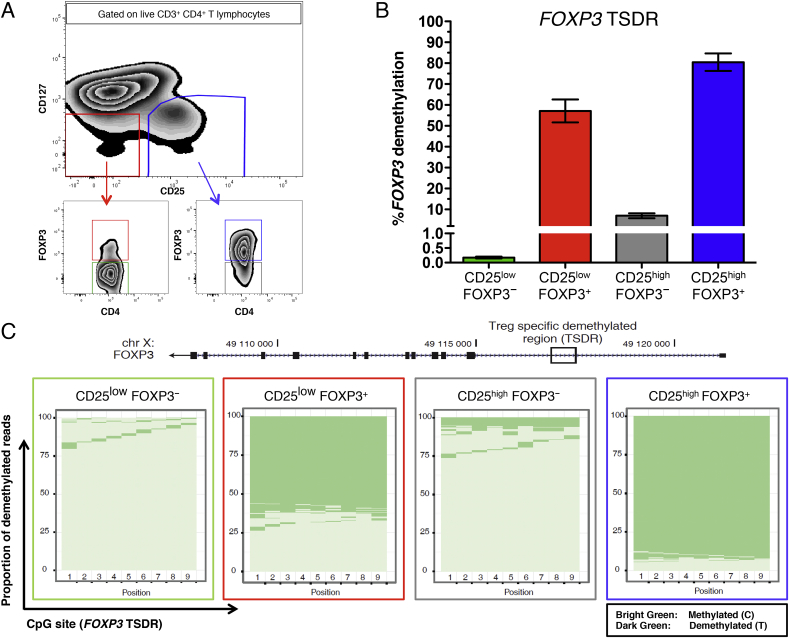
CD25lowFOXP3+cells are demethylated at the FOXP3 Treg-specific demethylated region (TSDR). (A) Gating strategy for FACS sorting of four CD4+ T-cell subsets: (i) CD127lowCD25lowFOXP3− (depicted in green), (ii) CD127lowCD25lowFOXP3+ (depicted in red), (iii) CD127lowCD25highFOXP3− (depicted in grey), and (iv) CD127lowCD25highFOXP3+ (depicted in blue). (B) Frequency (mean ± SEM) of reads demethylated at eight or nine of the nine interrogated CpG sites in the FOXP3 TSDR. The data were obtained from sorted cells from four independent healthy donors. (C) Graphic depicts the proportion of demethylated reads at the nine interrogated CpG sites from the FOXP3 TSDR in one illustrative donor. Each horizontal line represents one sequencing read, with light green representing a methylated read (C) and dark green representing a demethylated read (T). Note that the plot is representative of a male donor. For female donors, X-chromosome inactivation causes half of the reads to be methylated and a correction factor of two was applied to obtain the frequency of demethylated reads.